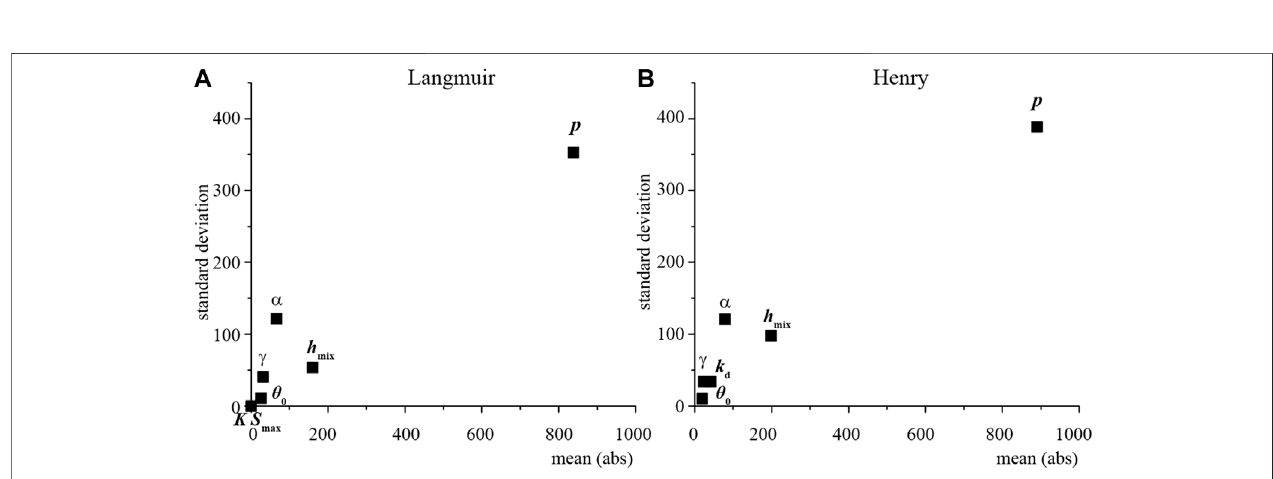
FIGURE 7 | The absolute mean versus standard deviation of element effect for each parameter at the runoff start time.